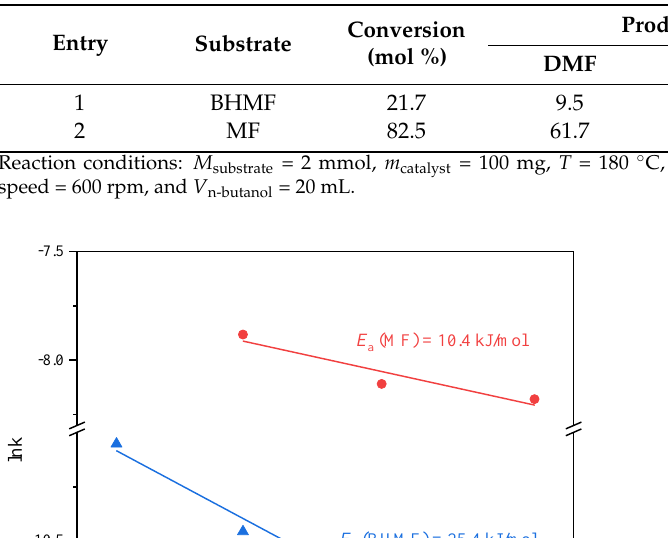
Table 3. Controlled experiments for DMF production from hydrogenolysis of intermediates.